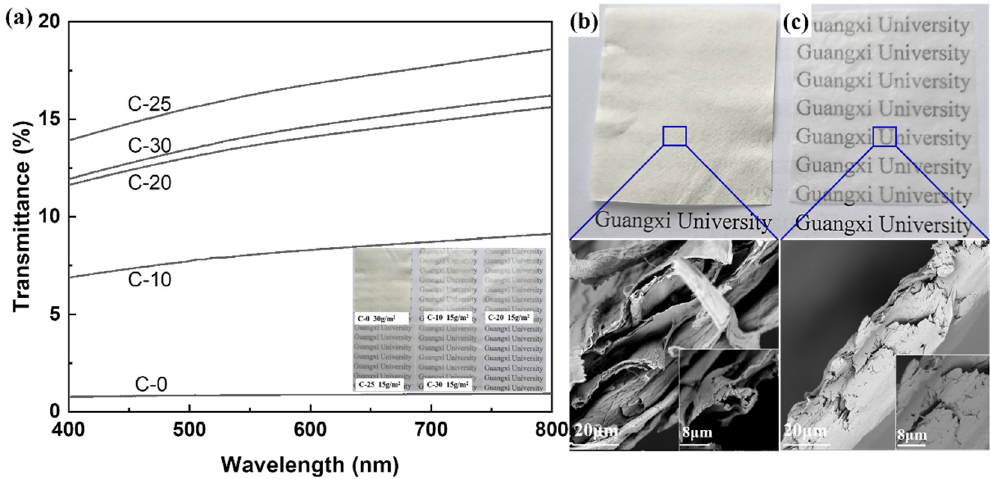
Figure 5. ( a ) Photo and optical transparency of films after different treatment stages, and ( b ) SEM micrographs and digital photographs of the raw material of C-0 film and ( c ) C-30 film after mechanical treatment.